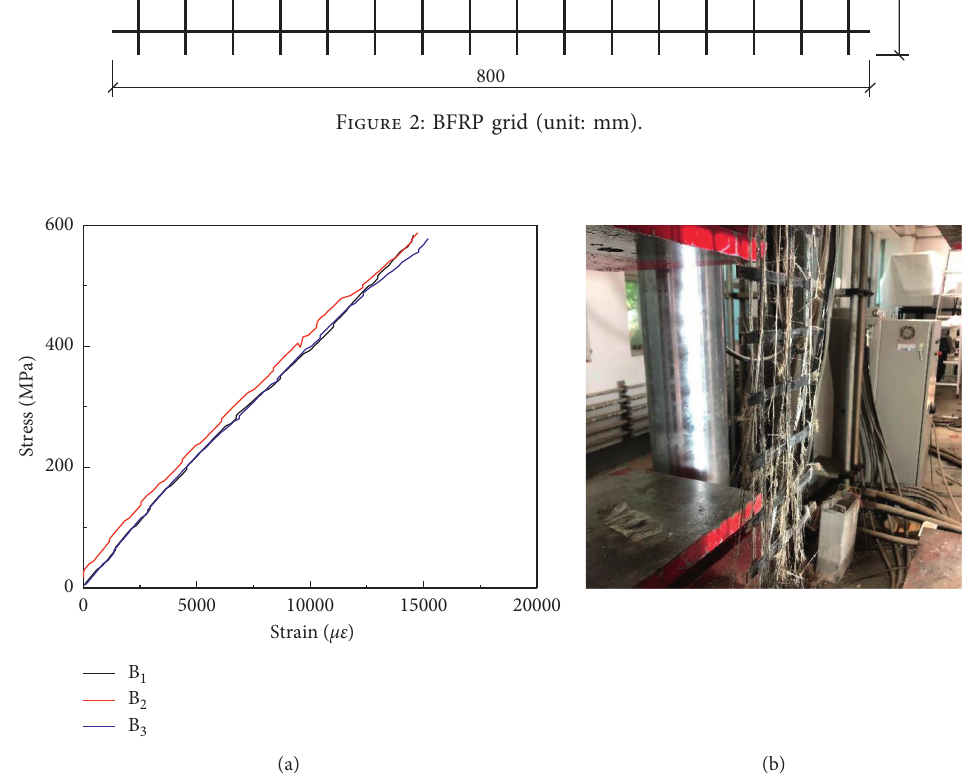
Figure 3: Axial tensile stress-strain curves and failure modes for the BFRP grids. (a) Stress-strain curves. (b) Failure